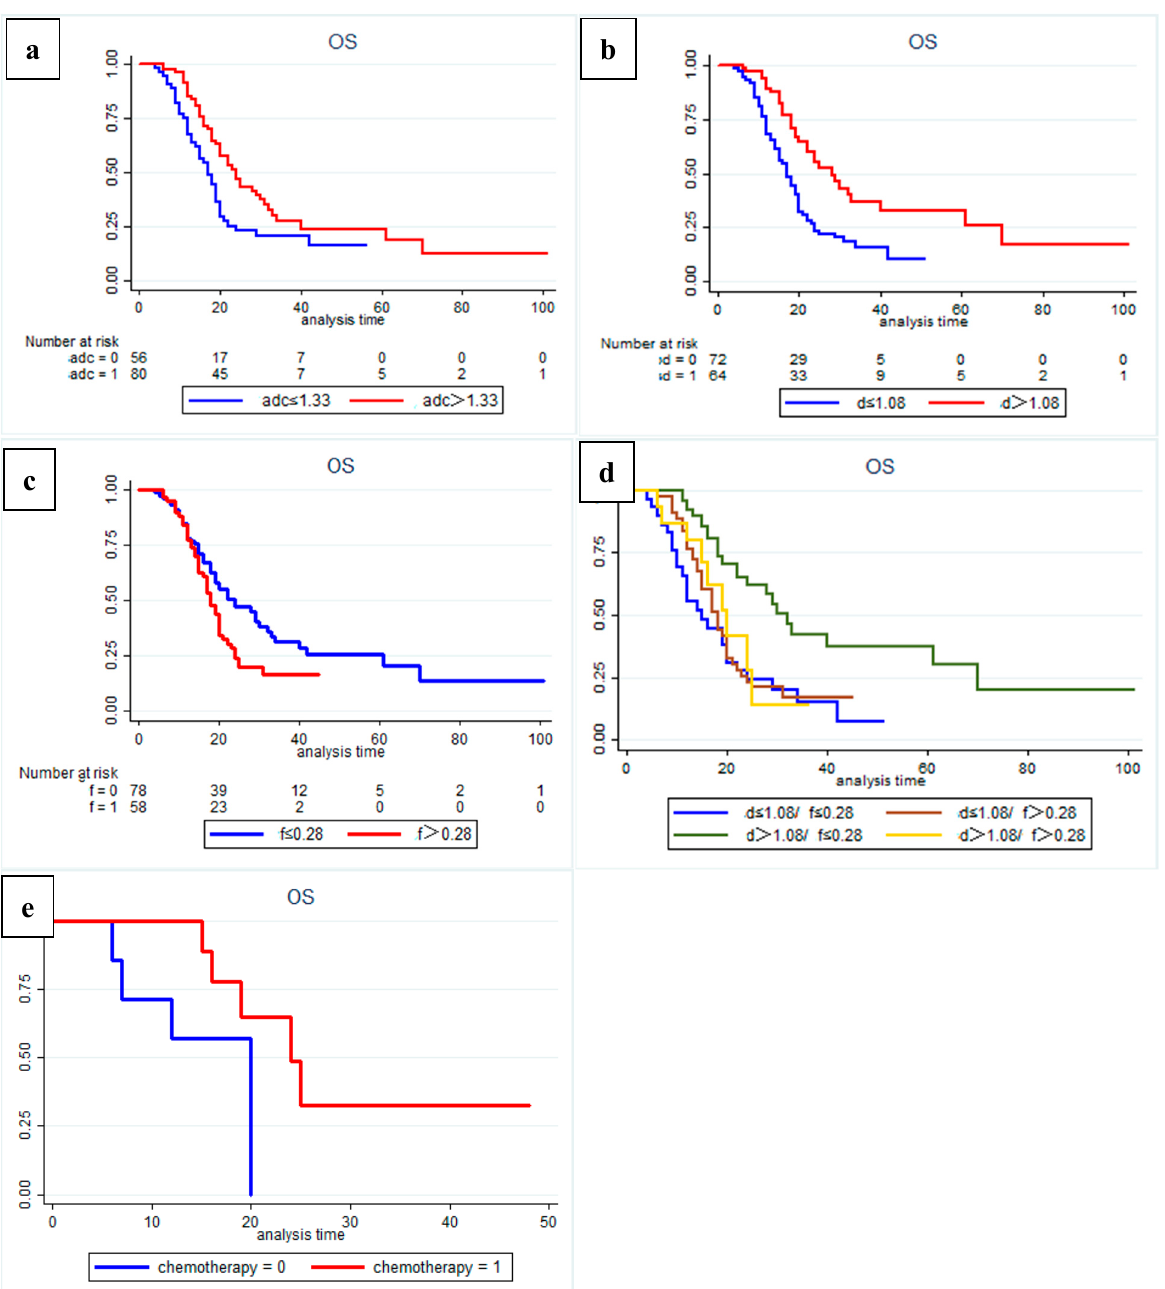
Figure 2. Kaplan–-Meier curves showing overall survival (OS) with clear differences between ( a ) high-ADC value group (sADC > 1.33 × 10 − 3 mm 2 /s) and low-ADC value group (sADC ≤ 1.33 × 10 − 3 mm 2 /s); ( b ) high-D value group (sD > 1.08 × 10 − 3 mm 2 /s) and low-D value group (sD ≤ 1.08 × 10 − 3 mm 2 /s); ( c ) low-f group (sf ≤ 0.28) and high-f group (sf > 0.28). ( d ) Subgroup analysis showed that patients in the high-D value combined with the low-f value group had a significantly better OS than patients in the other subgroups ( p = 0.001). Additional subgroup analysis also identified ( e ) a significant positive effect of postoperative adjuvant chemotherapy on overall survival for patients in the high-D value combined high-f value group ( p = 0.034).